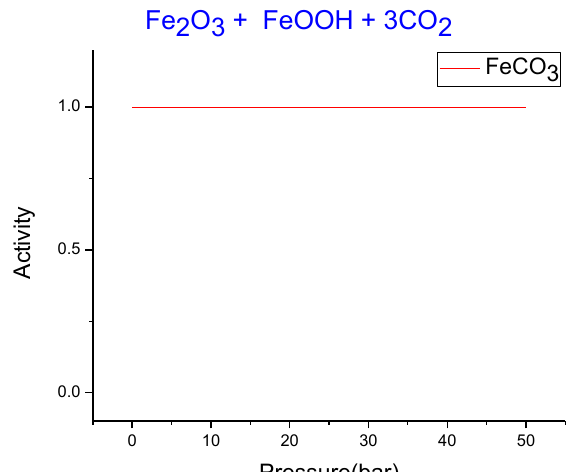
Figure 2. FACTSAGE simulation of siderite stability at 32 °C and various pressures for the system, iron ore – CO 2 .